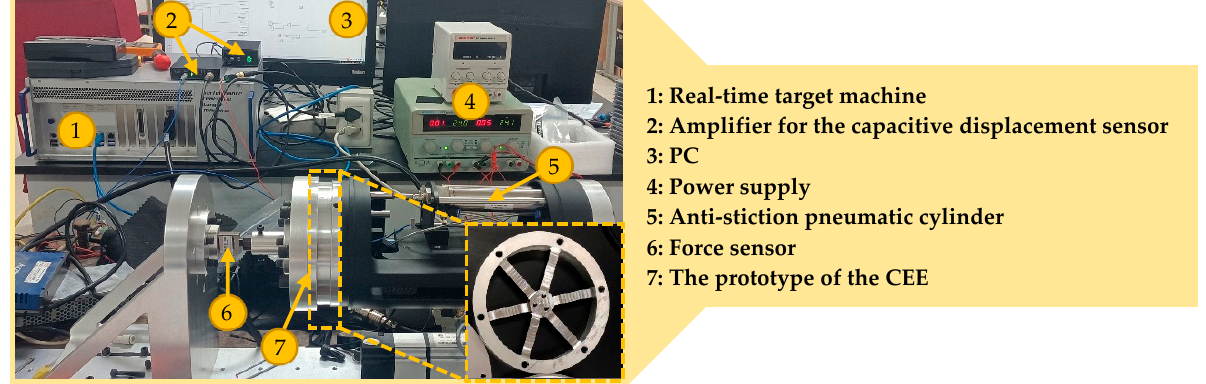
Figure 6. Experimental setup of the proposed CEE for robotic polishing.